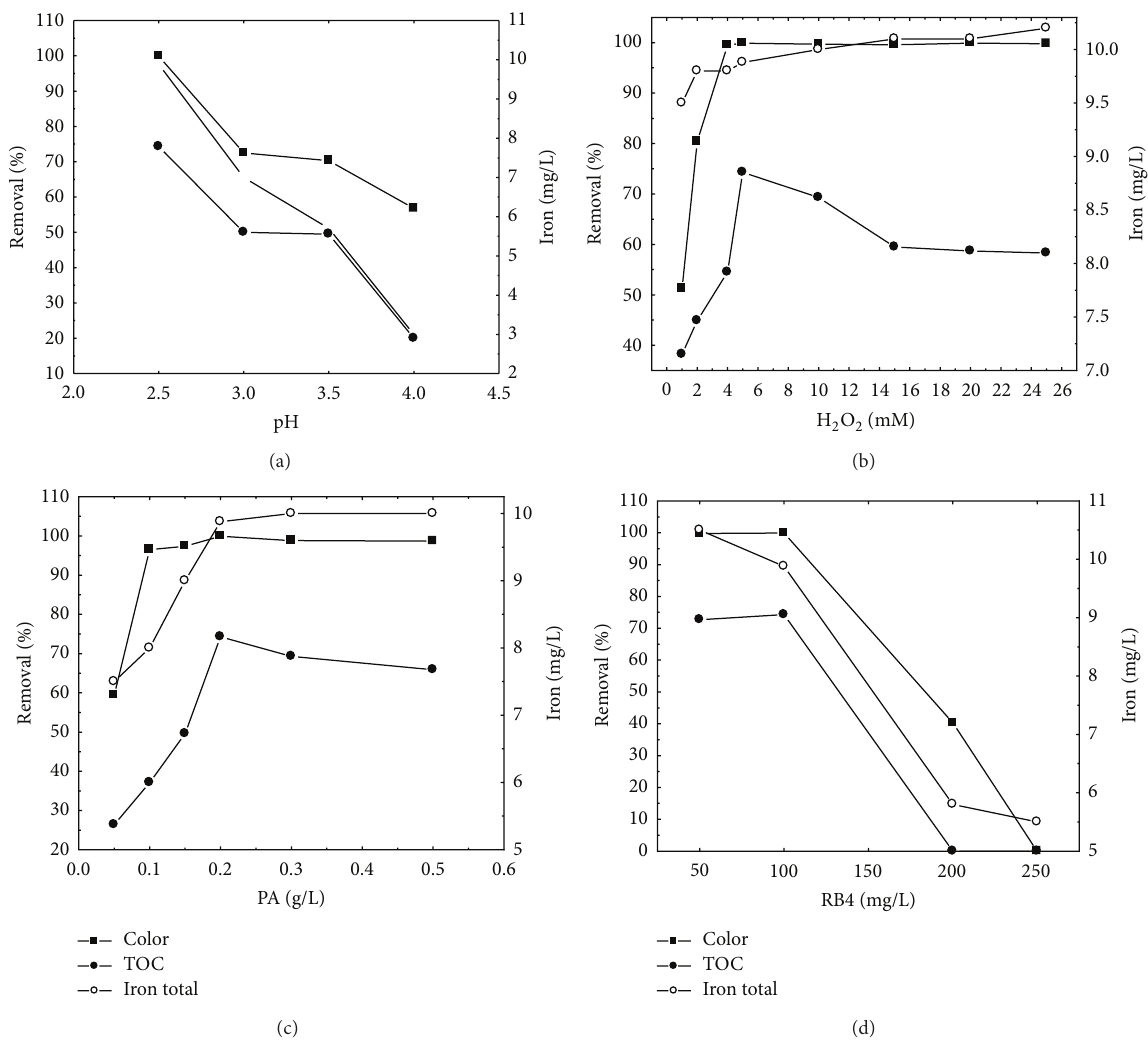
Figure 2: Effects of operational parameters on process efficiency and iron leaching: (a) pH; (b) H 2 O 2 concentration; (c) PA concentration; (d) RB4